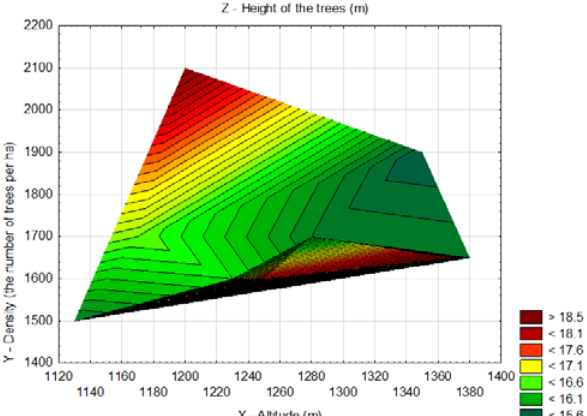
Fig. 3. The influence of altitude and density of spruce trees on the height of trees